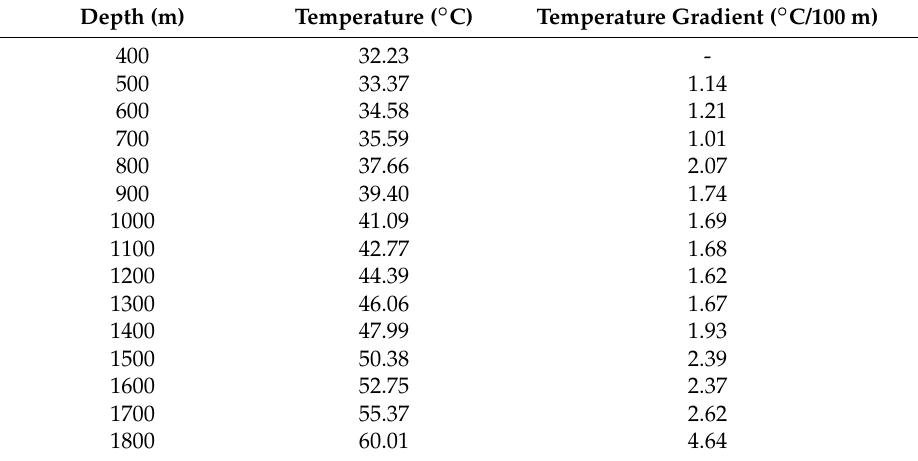
Table 3. Data of well temperature.